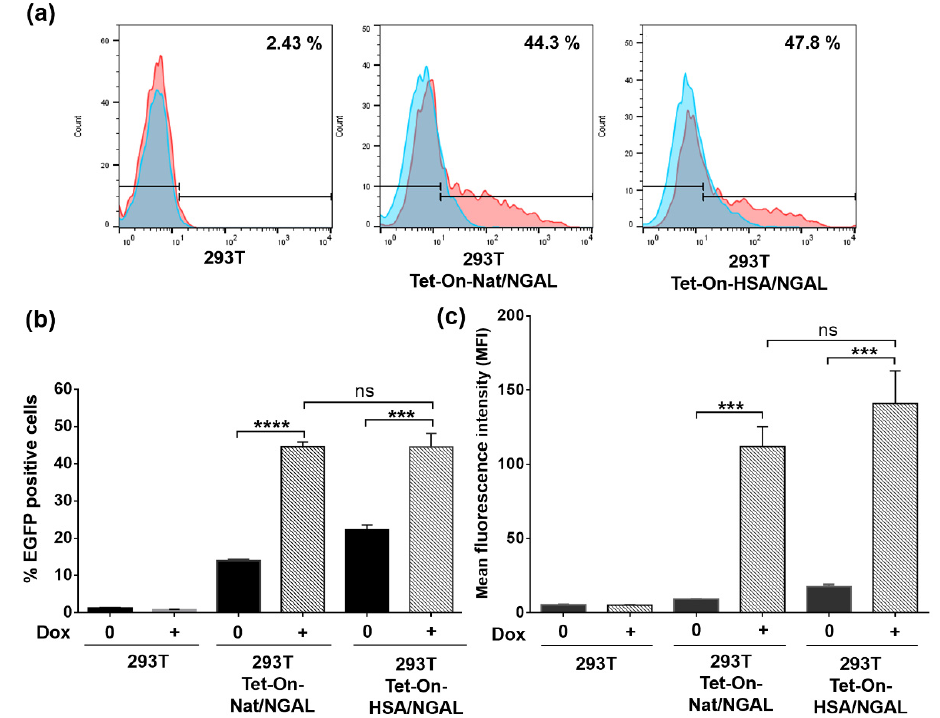
Figure 3. Flow cytometry analysis of EGFP-positive cells. ( a ) Representative overlay histograms showed the percentage of cells expressing EGFP. The blue and red peaks represented non-induced and Dox-induced conditions, respectively. ( b ) Percentage of EGFP positive cells and ( c ) MFI value were analyzed by FlowJo software. The results represented by triplicate experiments (mean ± SD). Data were analyzed using Student’s t -test (*** p < 0.001, **** p <